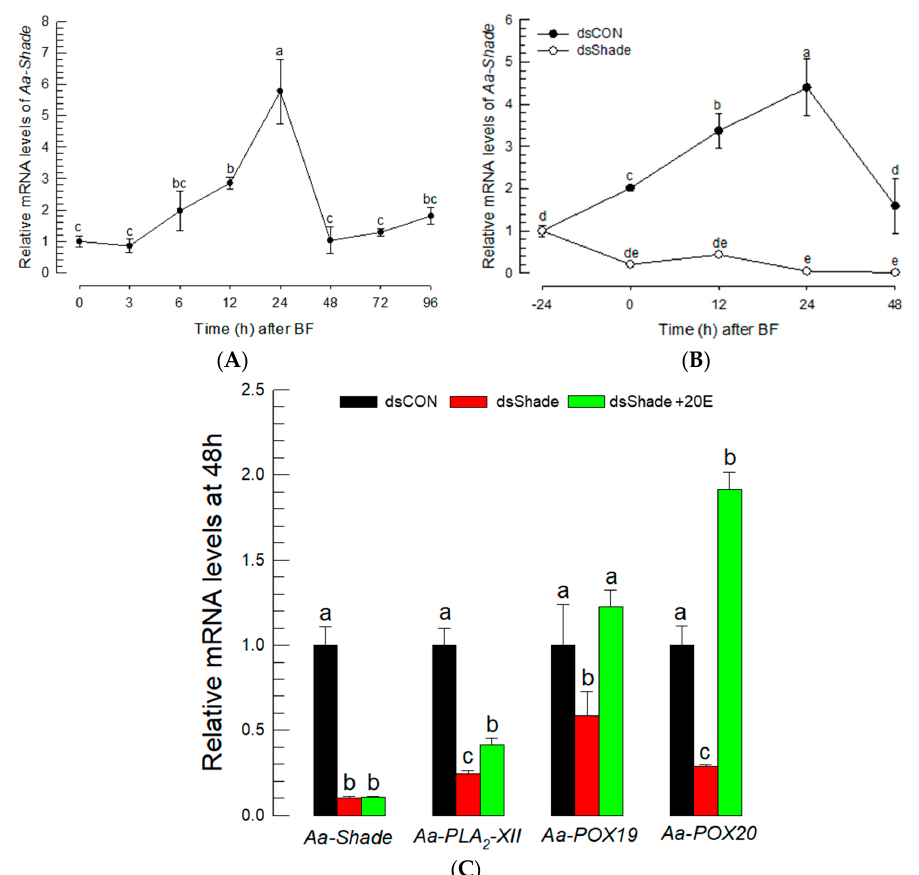
Figure 6. Suppression of PG biosynthesis-associated gene expressions by RNAi specific to a 20E biosynthetic gene, Aa-Shade , in Ae. albopictus . ( A ) Expression profile of Aa-Shade after blood-feeding (‘BF’). ( B ) Suppression of Aa-Shade expression by injecting its specific dsRNA (‘dsShade’, 300 ng/adult). ( C ) Suppression of the induced expressions of Aa-Shade , Aa-PLA 2 -XII , Aa-POX19 , and Aa-POX20 after BF by RNAi specific to Aa-Shade, and rescue by the addition of 20E. A GFP gene was used as a control dsRNA (‘dsCON’). Each treatment was replicated three times. The different letters above the standard error bars indicate significant differences among means at Type I error = 0.05 (LSD